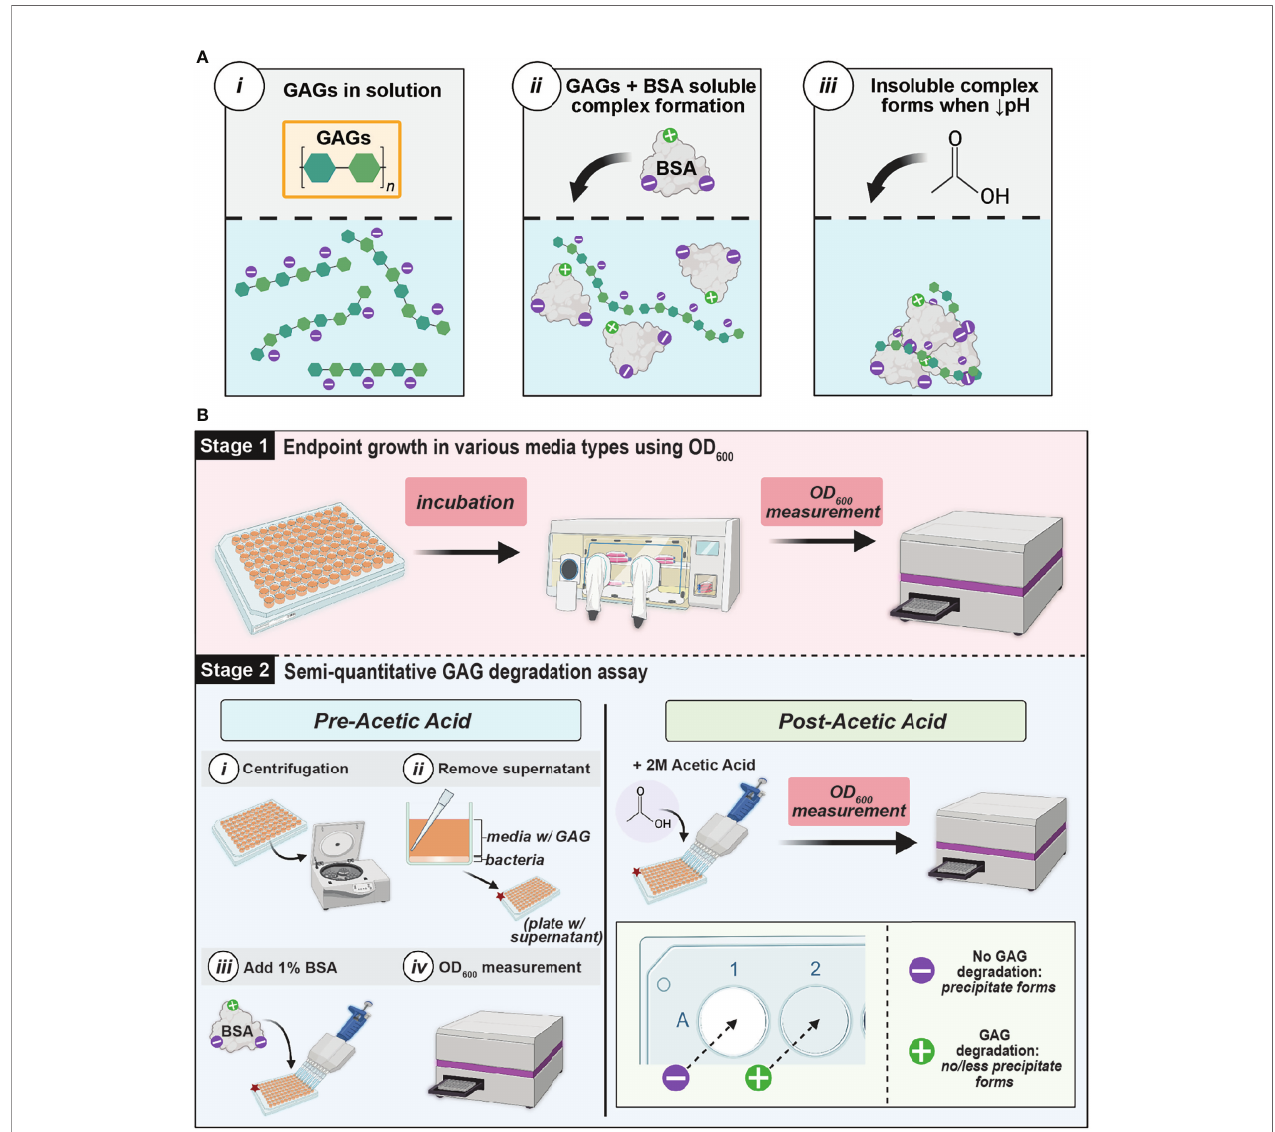
FIGURE 2 | GAG assay theory and work fl ow (A) Schematic of interaction between GAGs and BSA. GAGs and BSA form a soluble complex in solution (ii), but a decreased pH causes an insoluble complex to form and precipitate (iii) (B) GAG Growth and Semiquantitative Assay Method Work fl ow. Stage 1 involves measuring the endpoint growth of bacteria in media in the presence of GAGs versus glucose. Stage 2 evaluates GAG degradation by leveraging the precipitation of BSA complexed with remaining GAGs in the media supernatant at low pH. If there is GAG remaining after incubation, a white precipitate will form. However, if complete GAG degradation occurred, there will be no precipitate formation. The extent of GAG-BSA precipitation can be determined by measuring the optical density at 600 nm (OD 600 ). This fi gure was created using